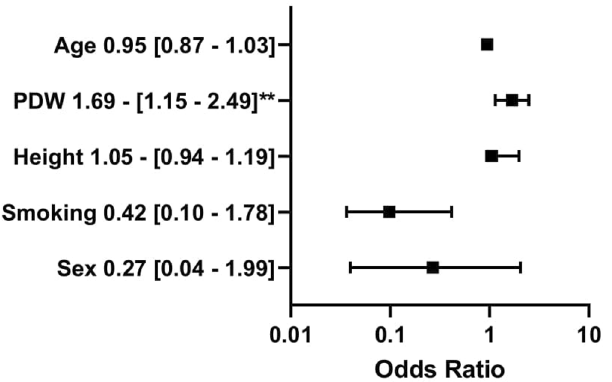
Figure 5. Multivariable logistic regression analysis with platelet distribution width. The dependent variable: the presence of brachial non-dipping pattern (coded one). The outcomes presented as a dependent variable (odds ratio, 95% confidence interval). *Significant at the 0.05 level; **significant at the 0.01 level; PDW platelet distribution width, DDI daily insulin intake. All figures made by authors of the manuscript. GraphPad Prism 9 (https:// www. graph pad. com/) was used to create forest plots.